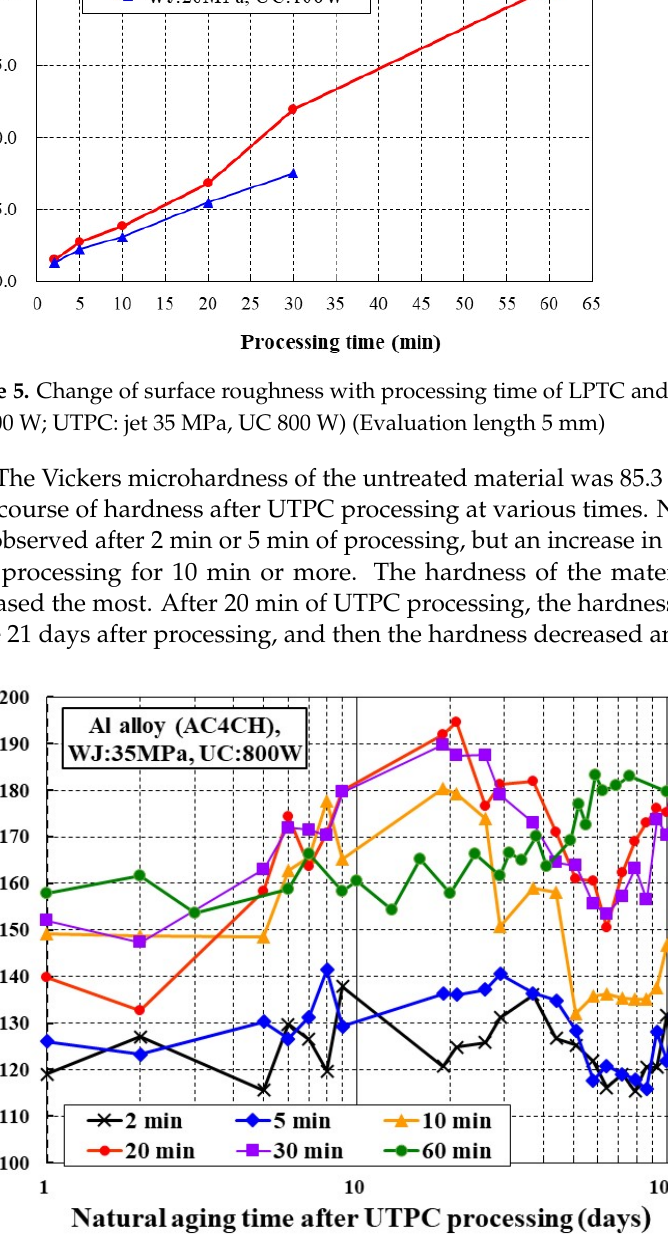
Figure 6. Relationship between hardness and elapsed time after UPTC processing (WJ: 35 MPa, UC: 800 W) (Average of standard deviation: 2 min 5.9 HV, 5 min 7.5 HV, 10 min 9.9 HV, 20 min 9.5 HV, 30 min 11.2 HV, 60 min 6.9 HV).